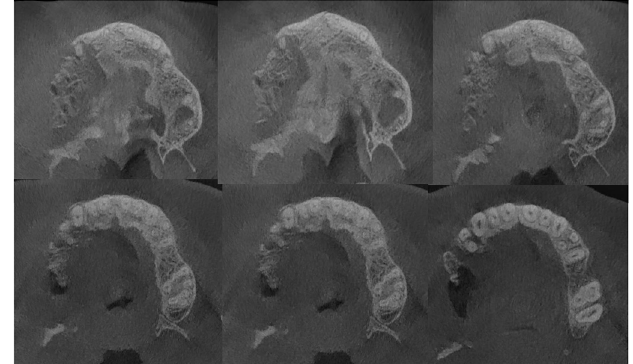
Image 2. CBCT, axial views of the maxilla. Single, heterogenous, low- density lesion with vague contours reminiscent of an osteonecrosis of the right hemi-maxilla reaching the mesio-palatal suture, the nasal cavities and the